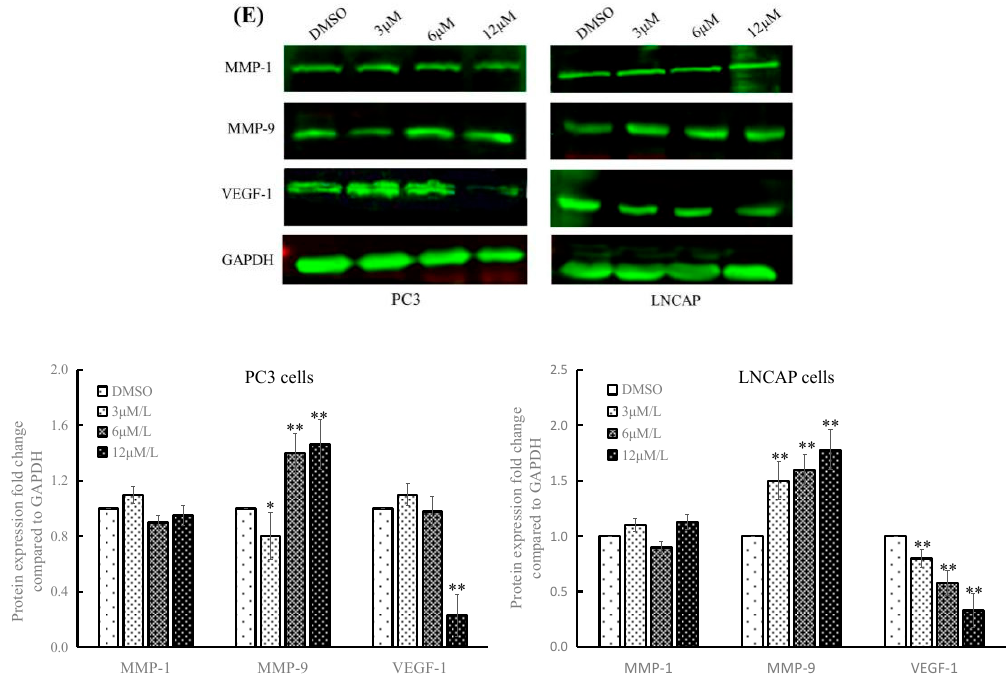
Figure 4. E ff ect of TC7 on migration and invasion ability of PCa cells. Migration ( B ) and invasion ( A ) of PC3 and LNCAP cells was evaluated by Transwell assay. Cells were treated with TC7 at di ff erent concentrations (3, 6, and 12 µ M) for 24 h. The number of migrated and invading cells were quantified and compared with the DMSO group. Scale bar = 100 µ m in all images. ( C , D ) E ff ect of lower concentrations of TC7 at relatively short treatment times on the invasion and migration of cancer cells. ( E ) E ff ect of TC7 on the expression of proteins involved in migration and invasion by western blot and quantified by Image J software. Results are presented as mean ± SD from three independent experiments. * p < 0.05 ( n = 3); ** p < 0.01 ( n = 3), compared with the control group; ## p < 0.01 ( n = 3), compared between two cancer cell lines.